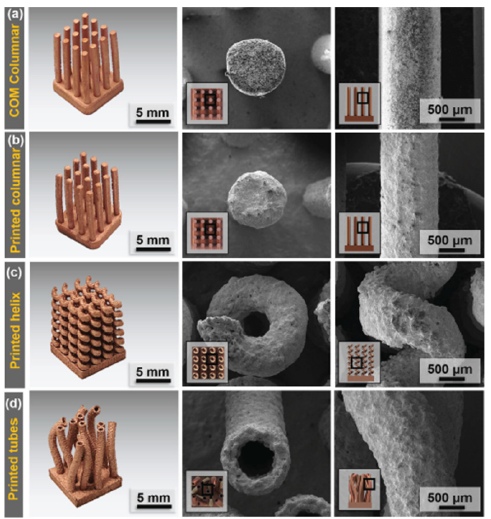
Figure 6. Top and side view photos ( a ) a commercial (COM) columnar, ( b ) a printed columnar, ( c ) a printed helix, and ( d ) a printed bent tubes heat sink. Reproduced with permission from [13], Elsevier, 2020.